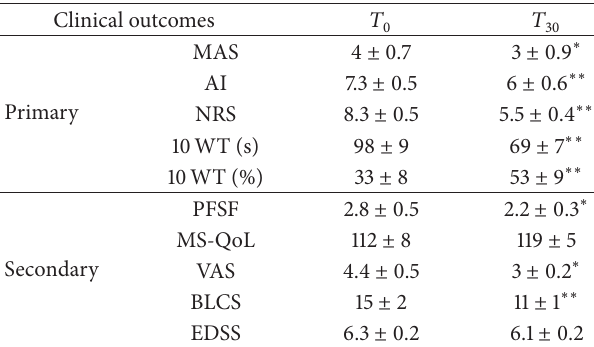
Table 1: Clinical effects after one month of Sativex medication. Data are reported as mean ± sd. The asterisk refers to the significant modification at 𝑇 30 , in comparison to 𝑇 0 ( ∗ 𝑃 < 0.05, ∗∗ 𝑃 < 0.01).